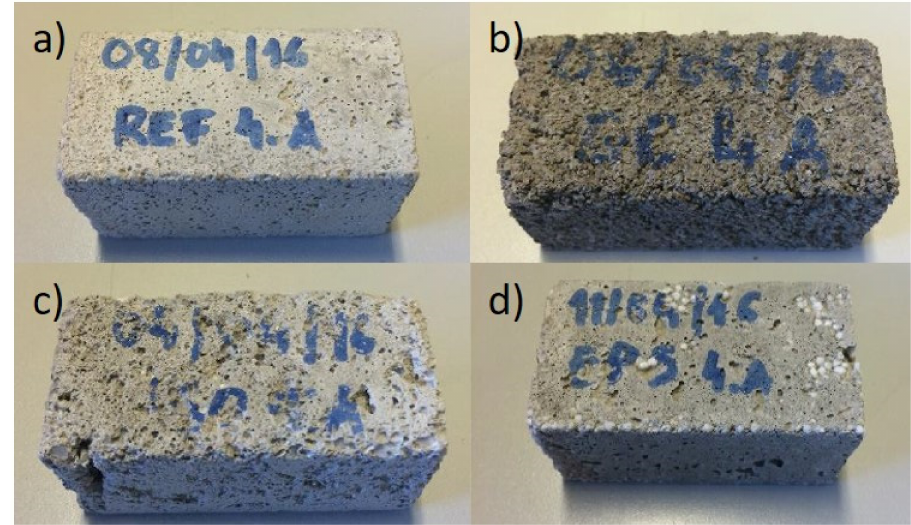
Figure 4. Half standard specimens after hygrothermal and IR accelerated aging cycles: ( a ) A(SS);